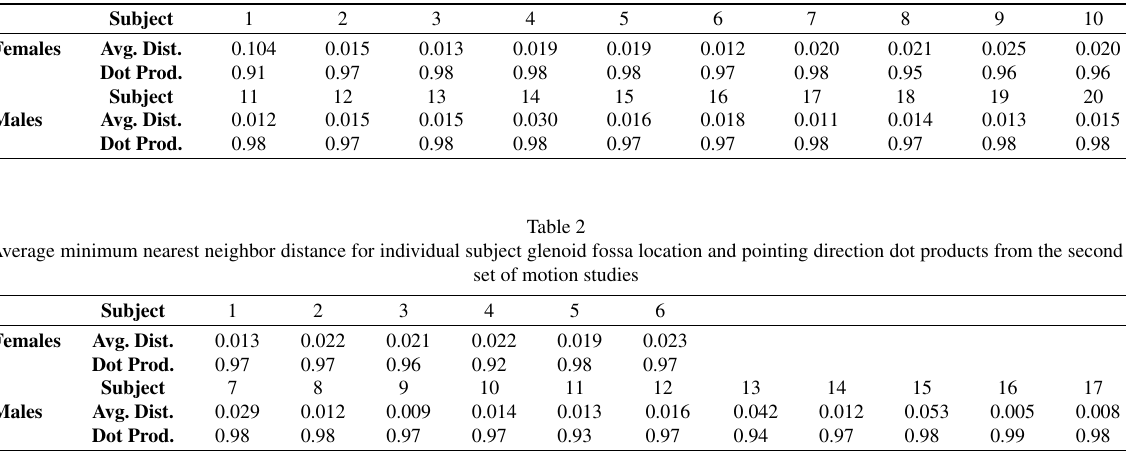
Average minimum nearest neighbor distance for individual subject glenoid fossa location and pointing direction dot products from the first set